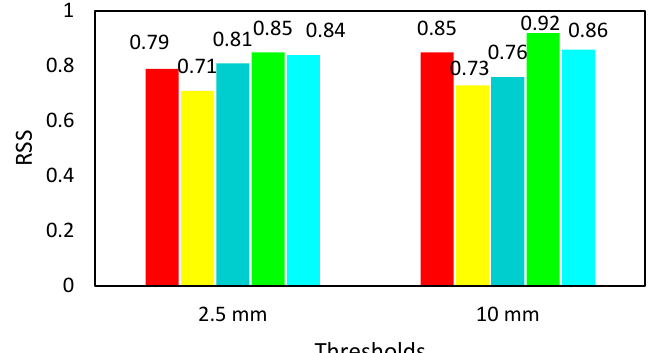
Figure 7. Comparison of RSS index for raw and post-processed ensemble precipitation forecasts.